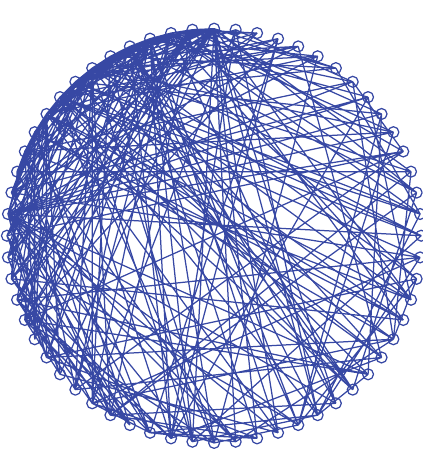
Figure 4: BA scale-free network graph.